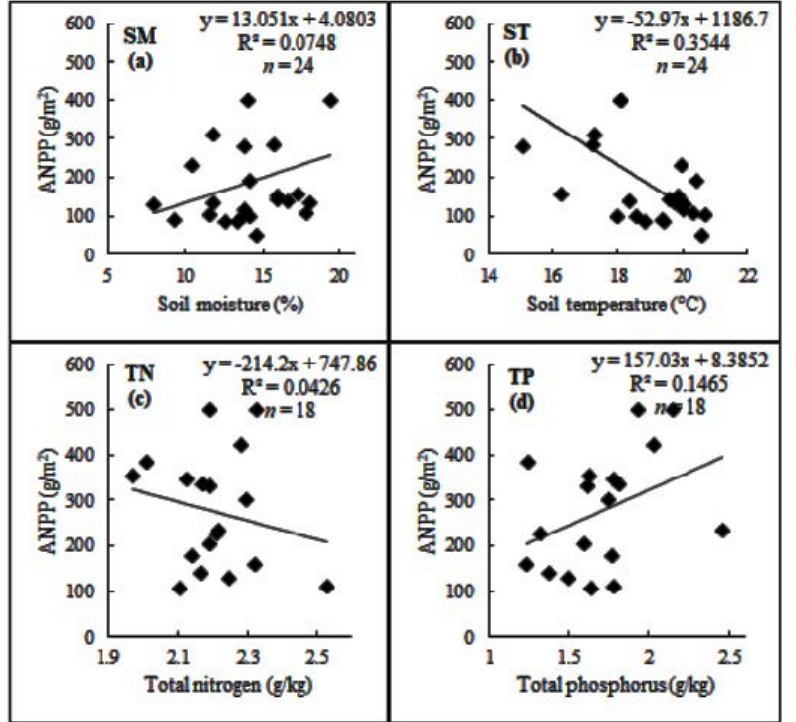
Figure 8. Relationships between ANPP and soil moisture (SM) ( a ), soil temperature (ST) ( b ), soil total nitrogen (TN) ( c ), and total phosphorus (TP) ( d ).